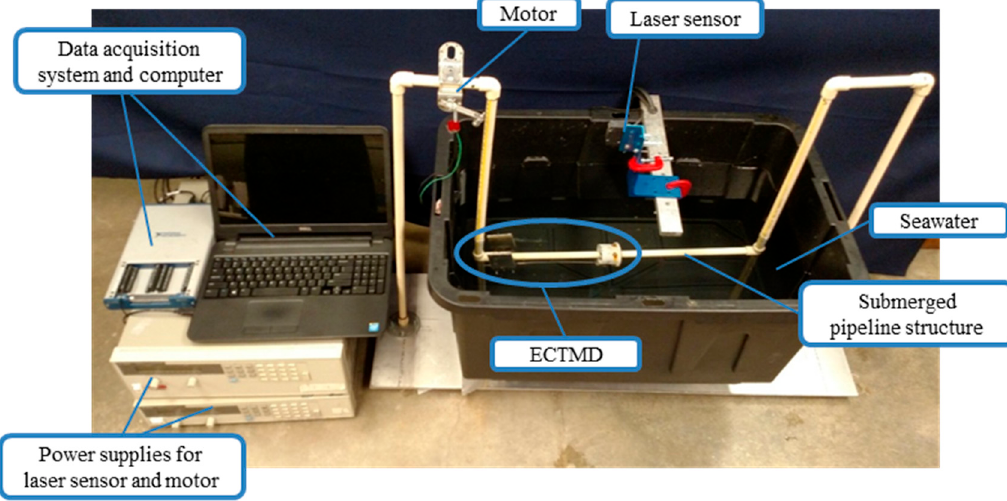
Figure 11. Experimental setup for the testing of the submerged pipeline.